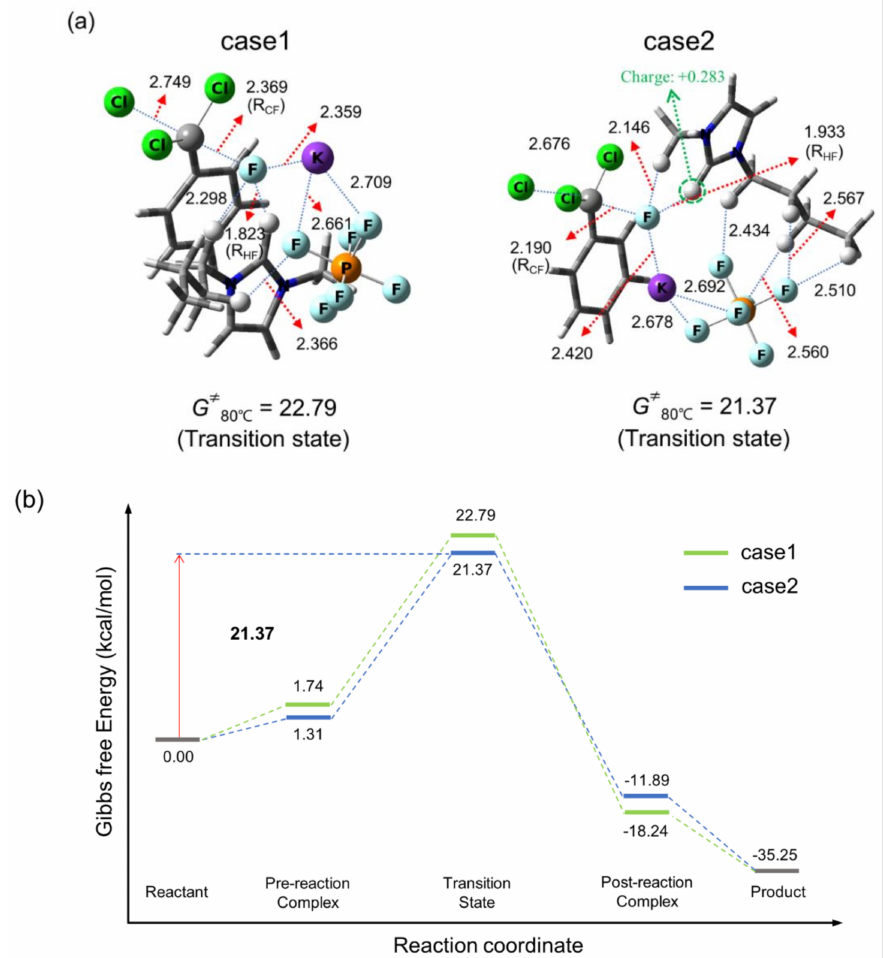
Figure 2. Calculated ( a ) transition states and ( b ) energetics of S N 2 fluorination in [bmim]PF 6 with substrate: KF =